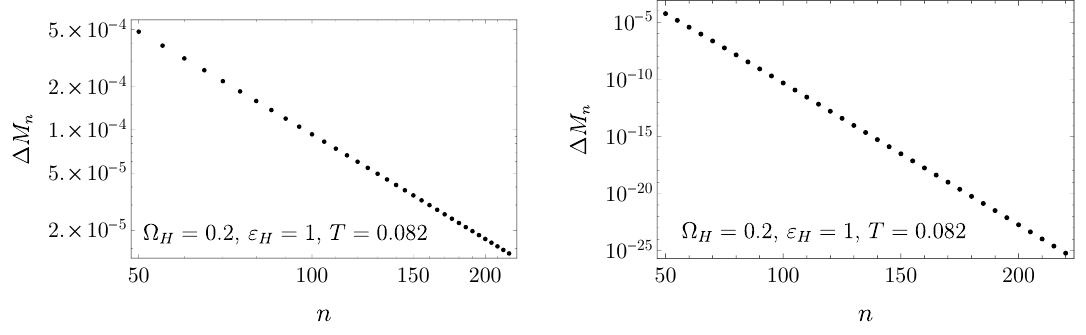
Figure 3 . Convergence of fractional error in black hole energy (cid:1) M n = j 1 (cid:0) M n +1 =M n j against the grid size n . Left : hairy black hole solution in DeTurck gauge. The scale is log-log, and the convergence is a power law. Right : convergence in radial gauge, for the same hairy black hole. The scale now is log-linear, exhibiting an exponential